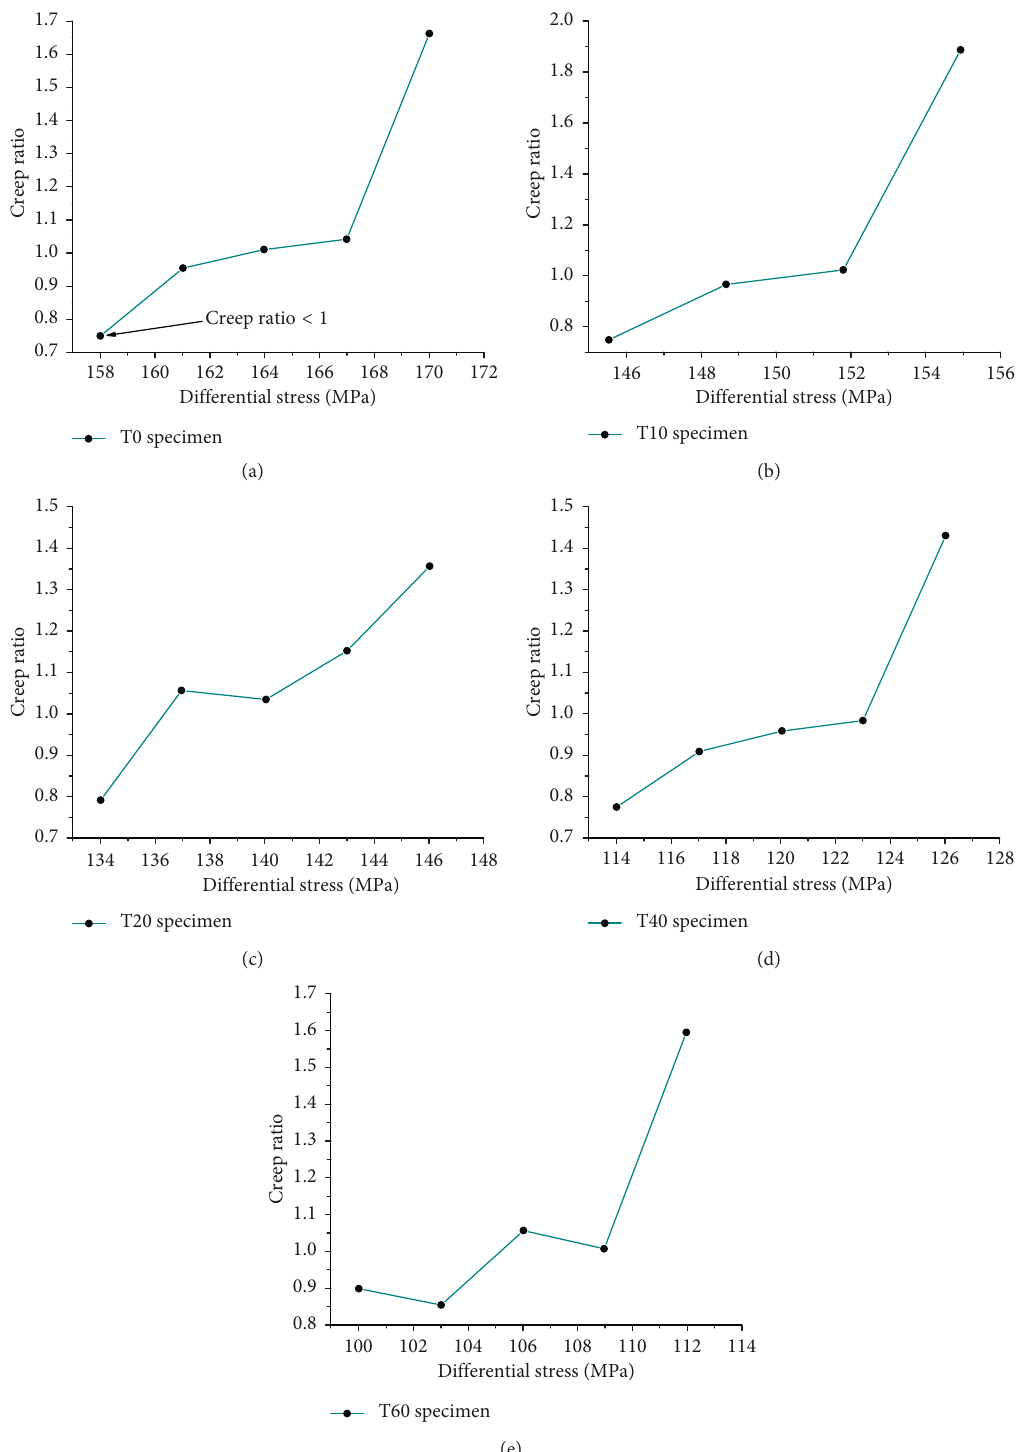
/ Δ ε ) with differential stress under different freeze-thaw cycles. (a) T0 specimen. (b) T10 specimen. 3 1